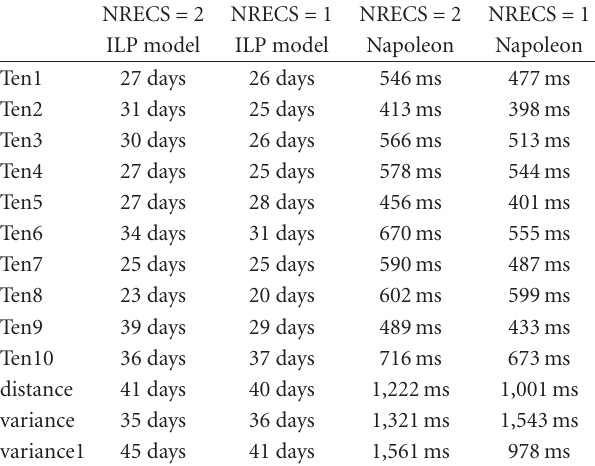
Table 5: ILP and heuristic execution